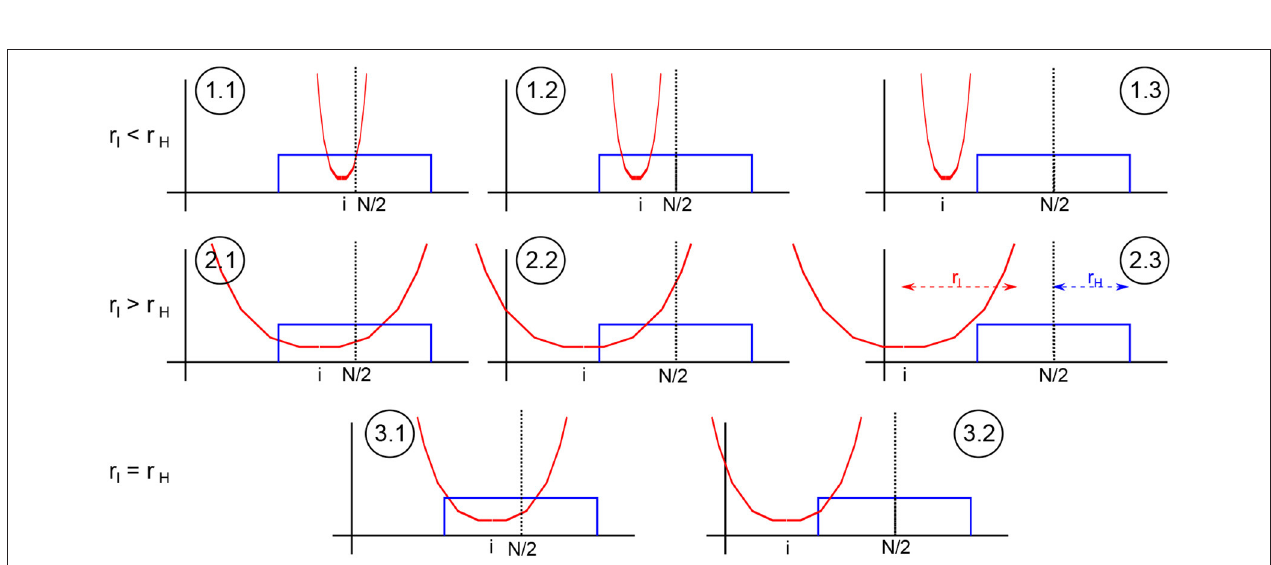
FIGURE 9 | Sketch of different configurations of sensitivity function and localization area. The circles denote the different cases (n.m) The sensitivity function (blue) has its center at the center of the spatial domain and the localization function (red) is located about model grid element i .